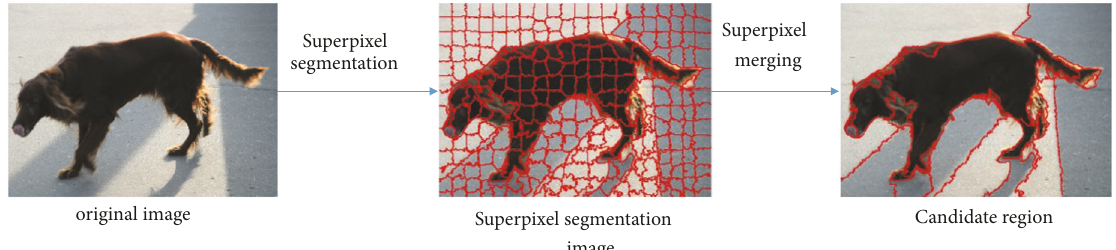
Figure 2: Flow chart of candidate region segmentation based on superpixel.